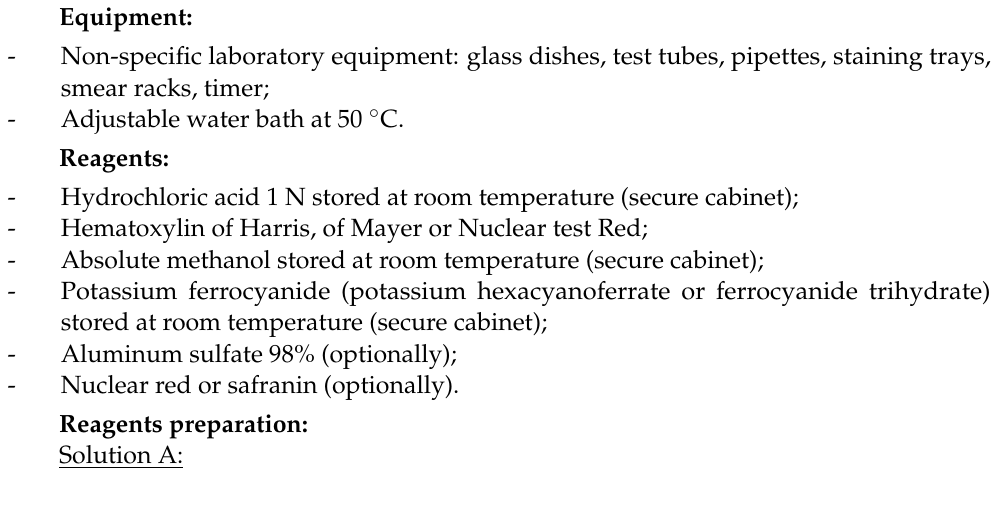
Figure 3. Technical protocol of Perls’ Stain.